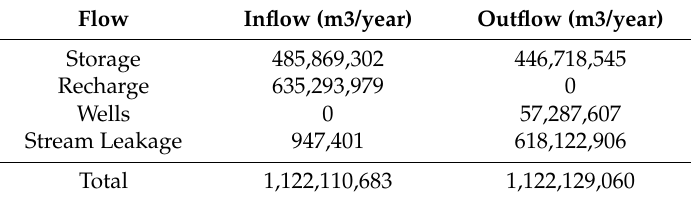
Table 4. Mean annual groundwater budget in m 3 /year in the Klela basin from November 2010